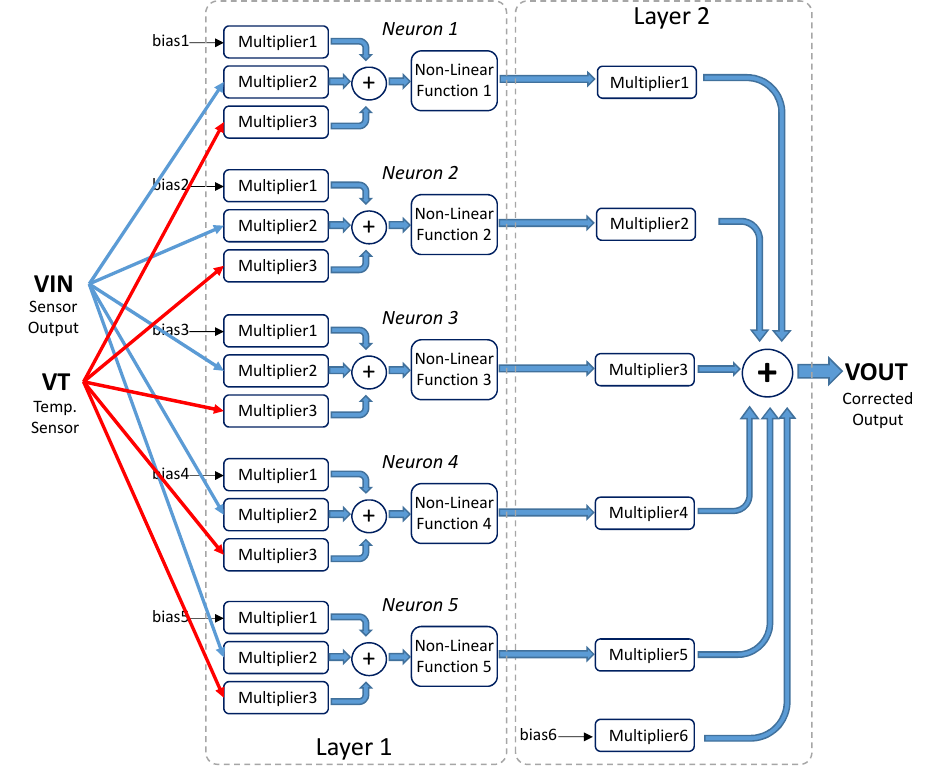
Figure 22. ANN architecture used to correct temperature